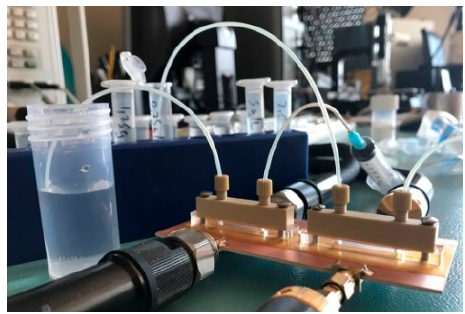
Figure 7. Setup for experimental sensor verification in the laboratory.